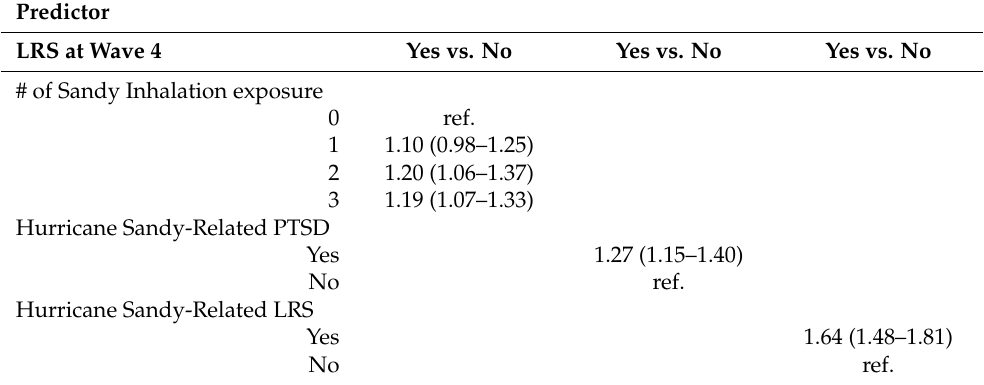
Table 2. Adjusted Risk Ratios (aRR) for the association between Lower Respiratory Symptoms (LRS) at wave 4 and Hurricane Sandy exposures in 2015–2016 among the World Trade Center Health Registry enrollees *.